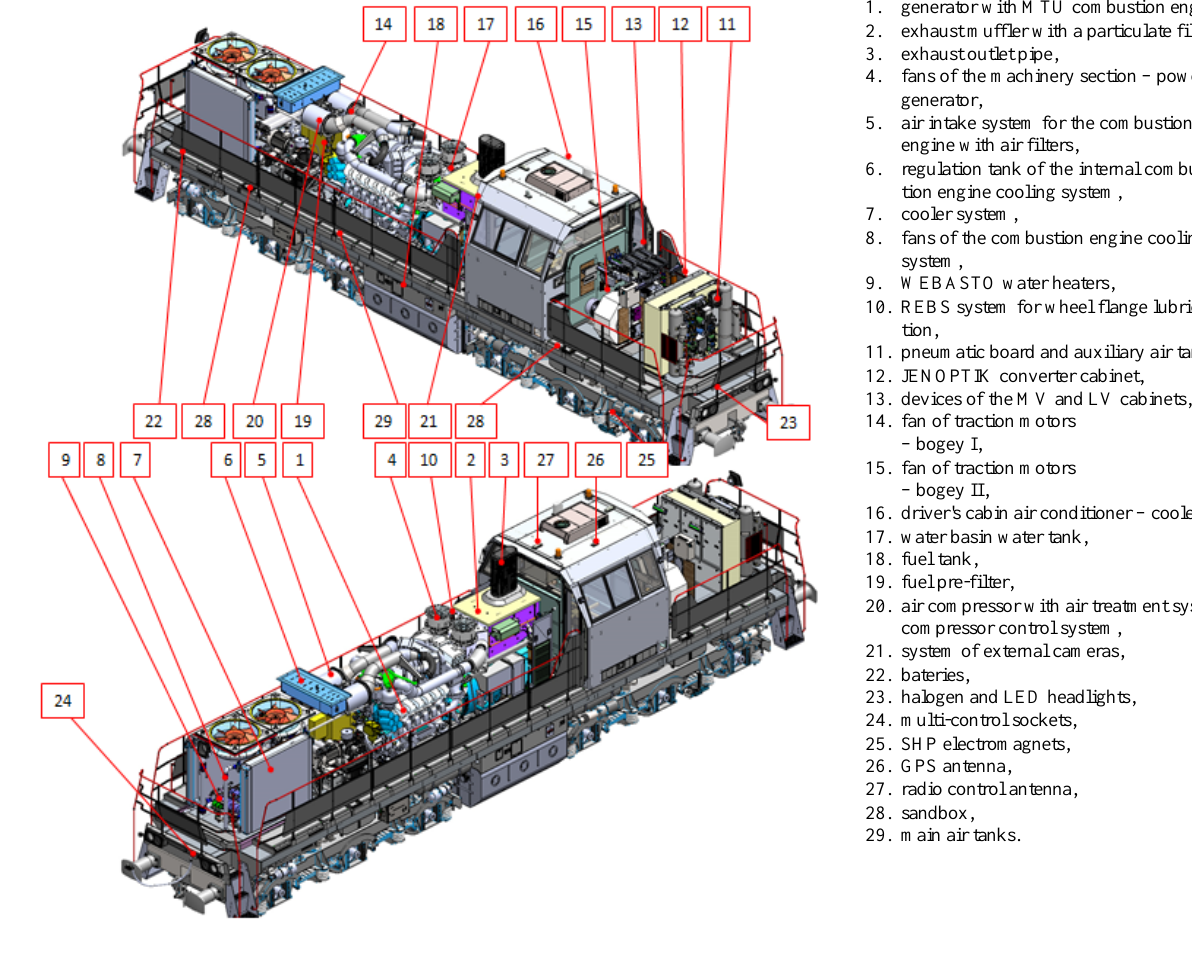
Fig. 13. Arrangement of the main components on the 19D